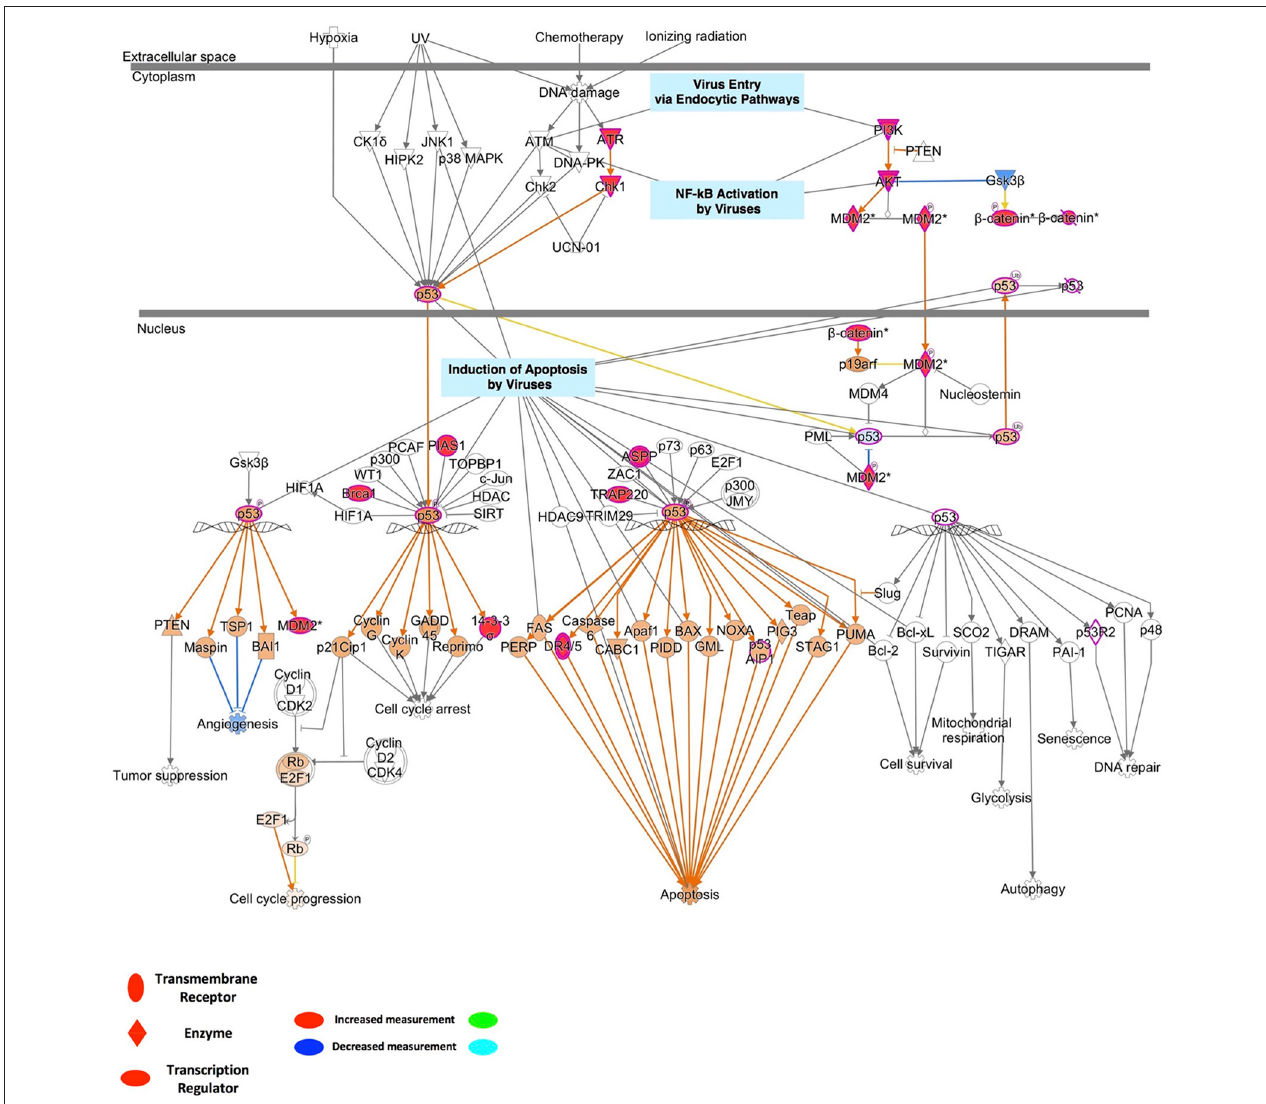
FIGURE 2 | Detailed information on the key regulatory factors involved in P53 signaling that play important roles in the activation of apoptosis by